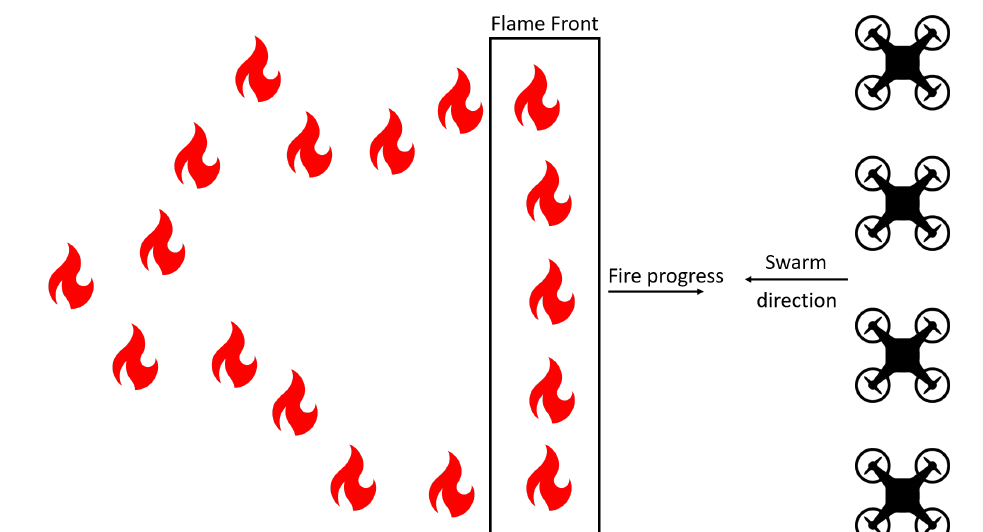
Figure 4. Action in line formation in front of a